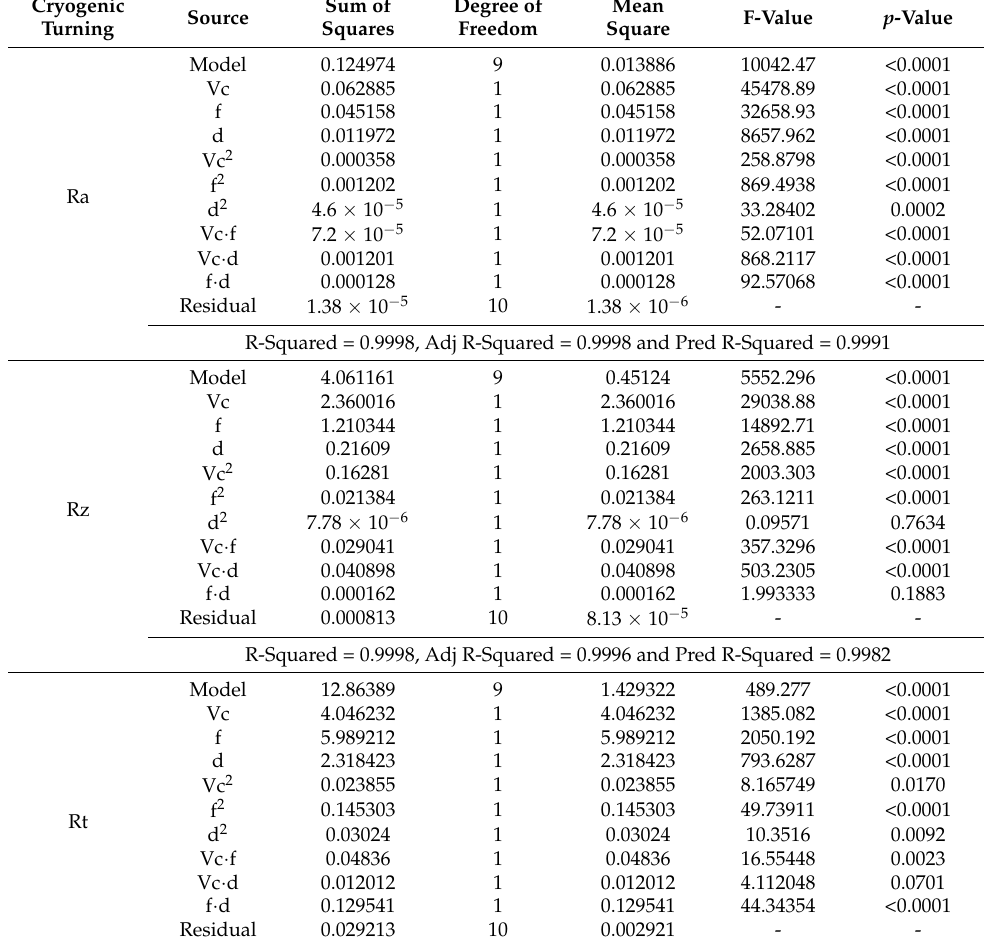
Table 6. ANOVA table for surface roughness for cryogenic turning. Cryogenic Turning